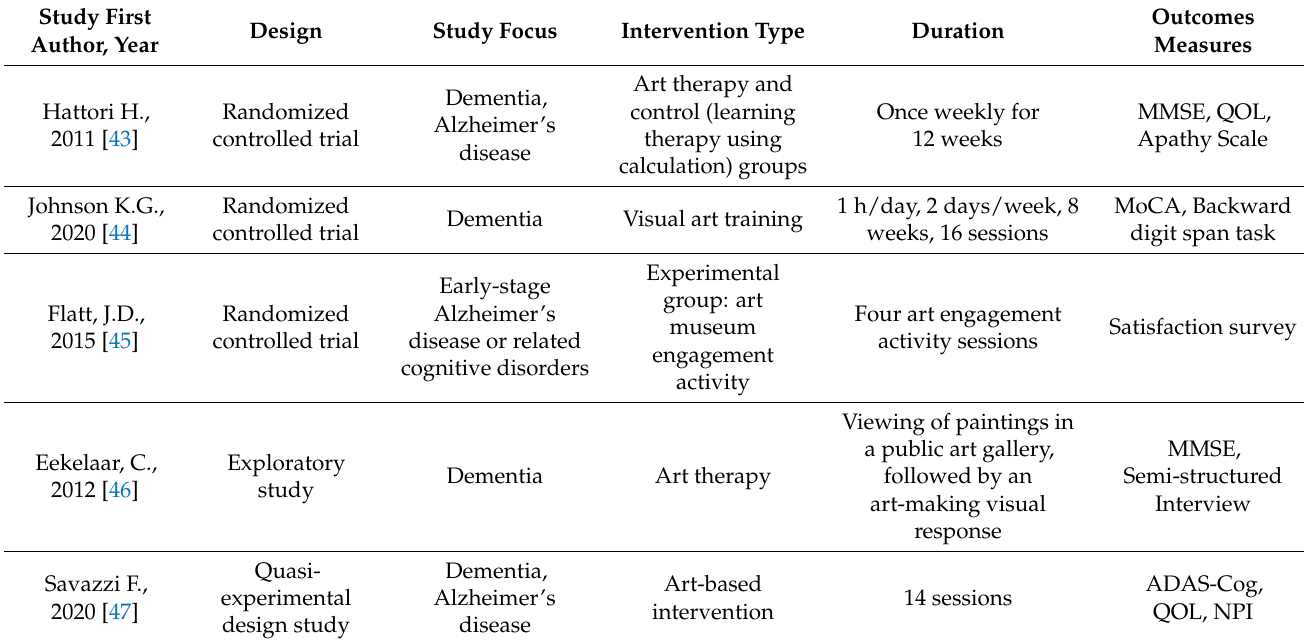
Table 4. Studies characteristics regarding art